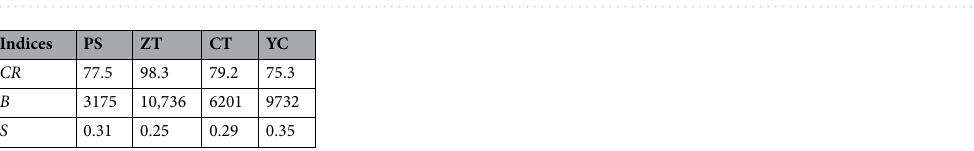
Figure 4. Uncertainty interval of monthly mean runoff at the 95% confidence level during the validation period. ( a PS station; b ZT station; c CT station; d YC station). The figure was generated by MATLAB2019a (https:// www. mathw orks. com/).